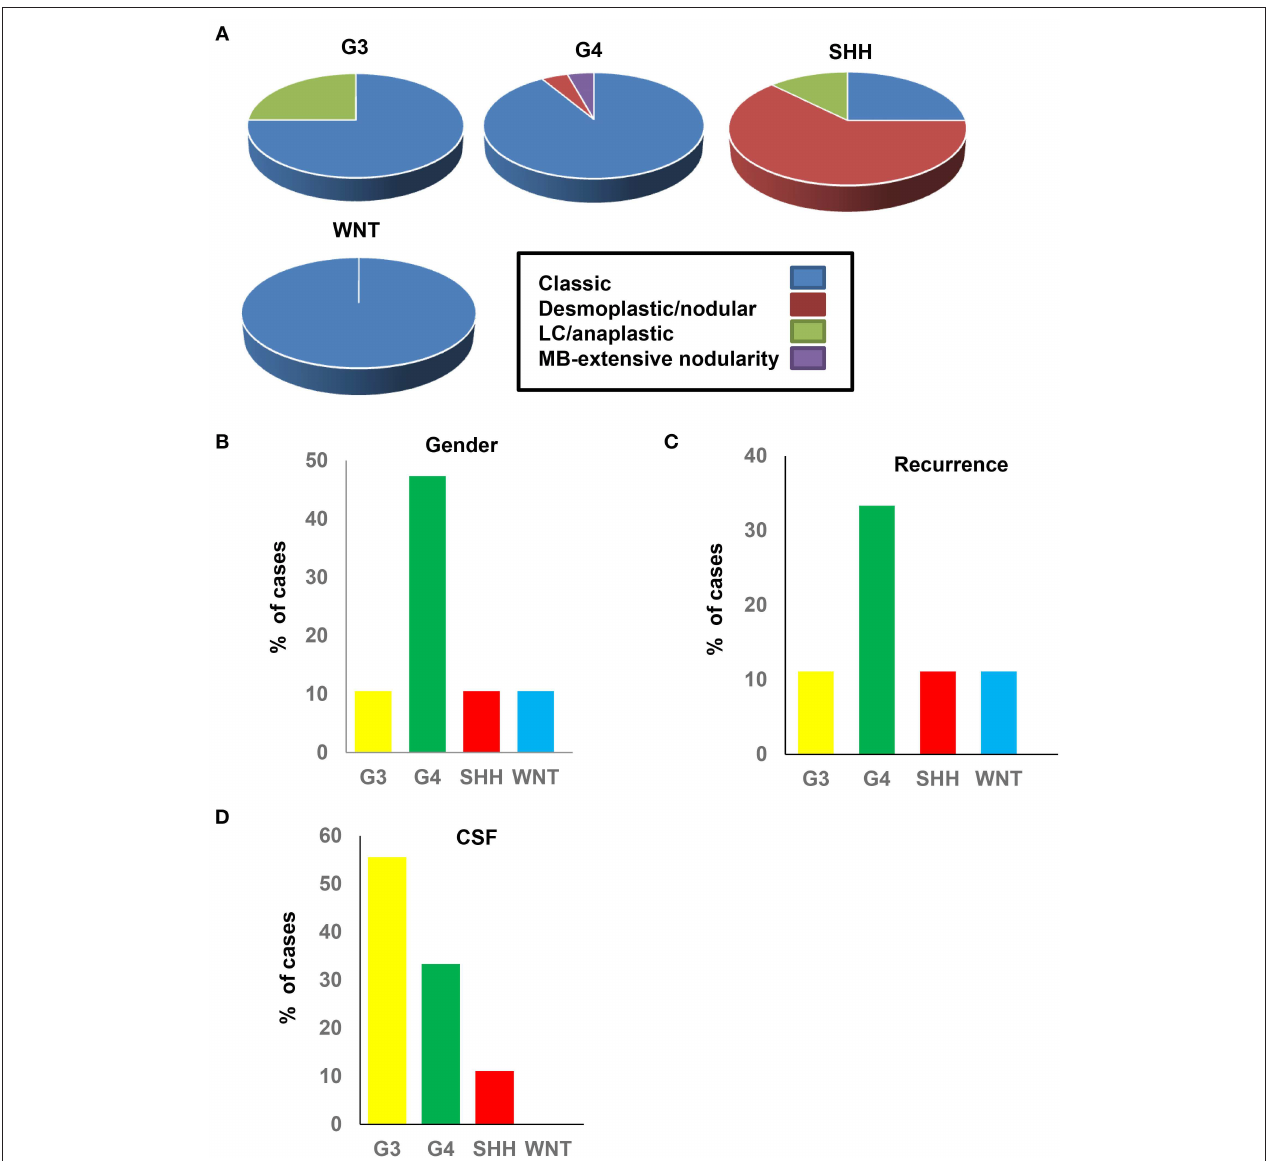
FIGURE 3 | Clinical and pathological data of the medulloblastoma methylation subgroups. (A) Histological classification in each subtype. (B) Gender percentage in each subtype. (C) Percentage of recurrence in each subtype. (D) CSF percentage dissemination in each subtype.